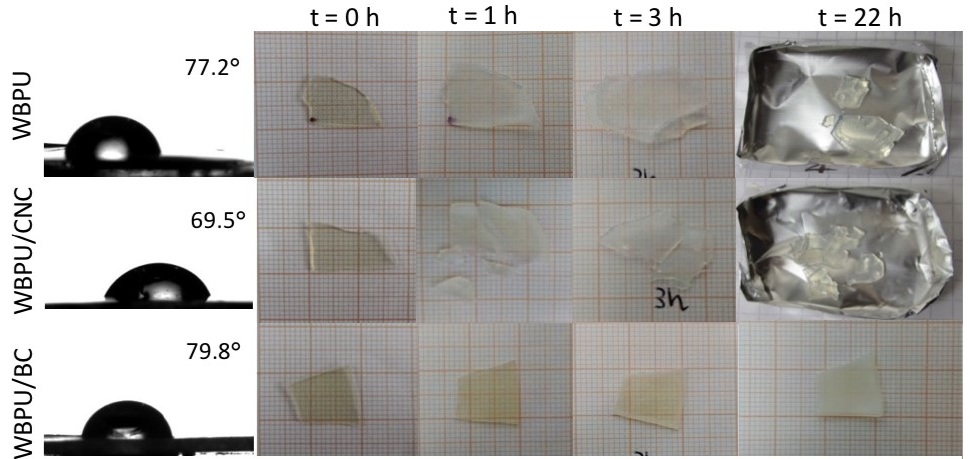
Figure 8. Behavior of the films in contact with water: contact angle and water immersion effects on the integrity of the films. the integrity of the